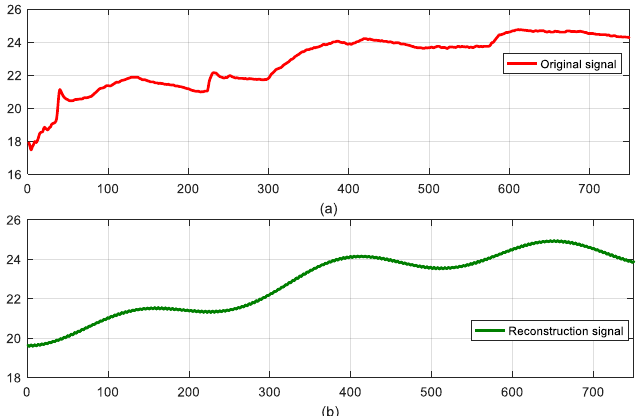
Figure 13. Comparison between original signal and reconstruction signal ( a ) original signal ( b ) reconstruction signal.